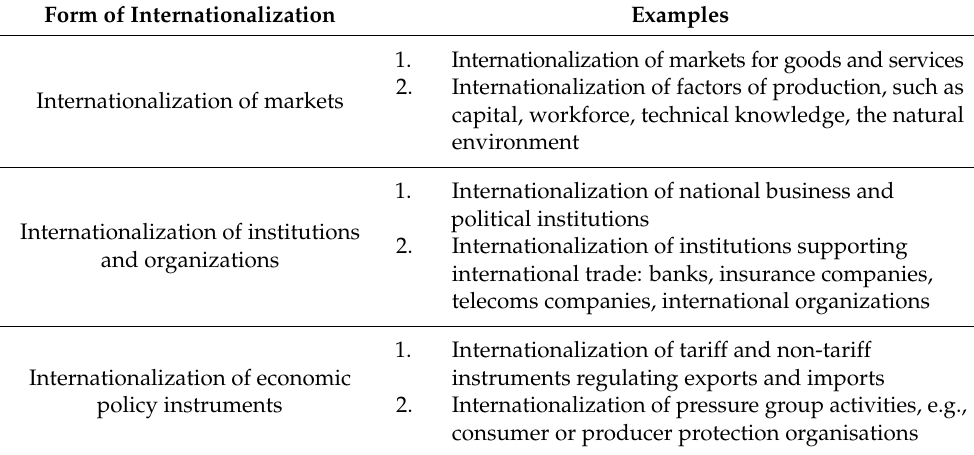
Table 2. Forms and examples of the internationalization of markets, institutions and economic